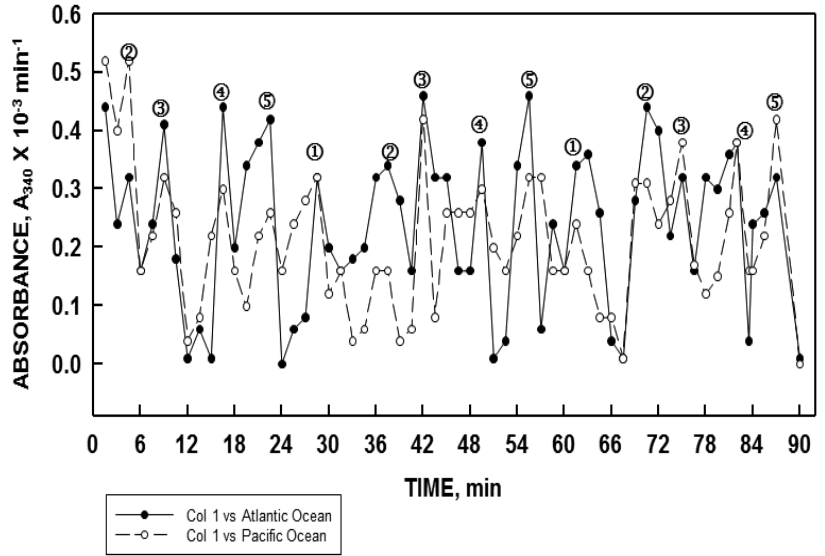
Figure 10. Water sampled simultaneous from the Atlantic Ocean at Ocean City, Maryland (solid line, closed symbols) and from the Pacific ocean at San Diego, California (dashed line, open symbols) exhibited similar synchronous oscillatory patterns when analyzed in parallel.